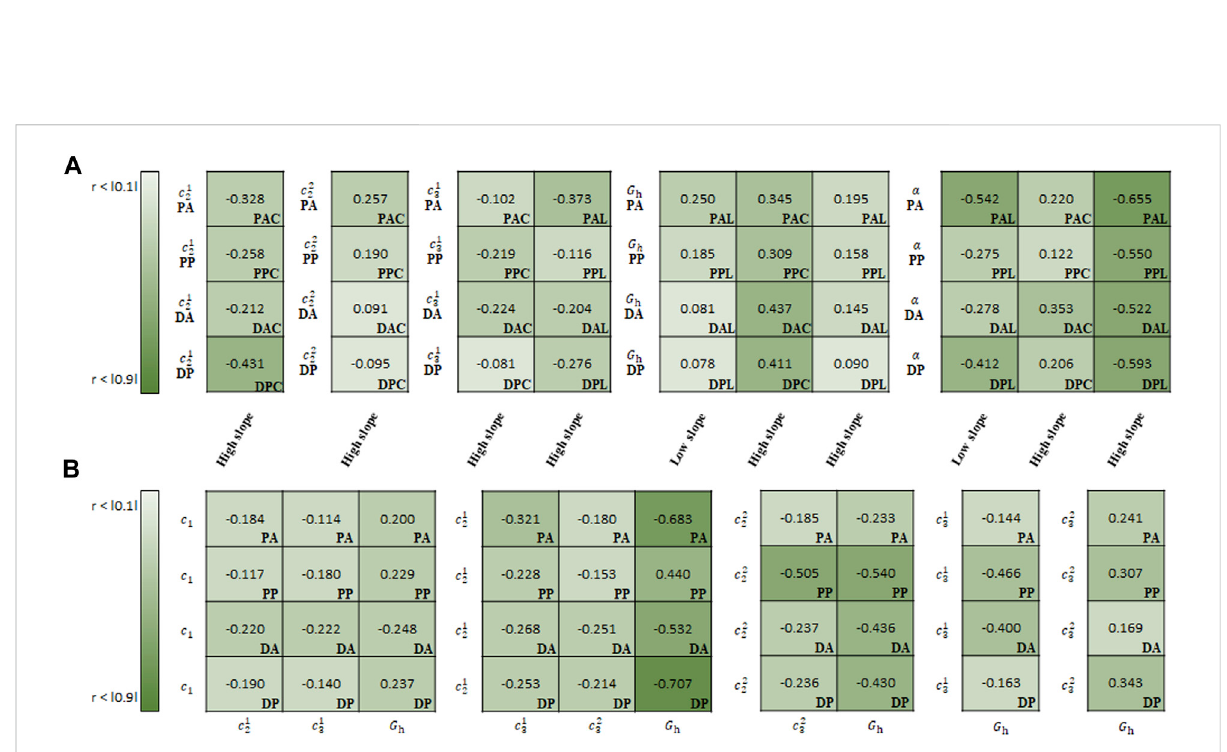
FIGURE 11 Spearman rank correlation coef fi cients (A) between material parameters of CMM and experimental results and (B) among the material parameters.